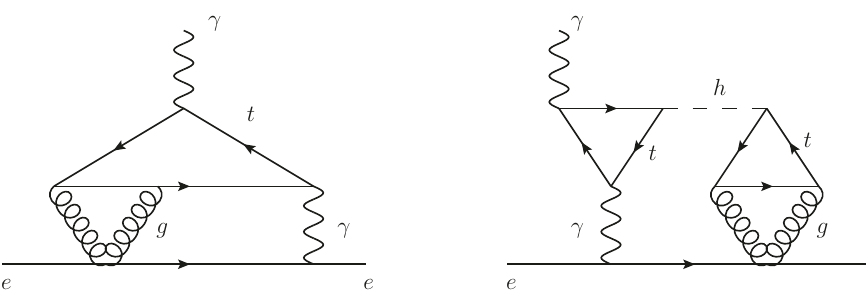
Figure 3 . Representative Feynman diagrams of three (left) or four (right) loop contribution to direct electron EDM from CP-odd electron-gluonic operators. There is no two-loop diagrams con- tributing, because the only diagram at two-loop level is to remove the internal photon line from the left (cid:12)gure. However, this two-loop diagram is forbidden by Furry’s theorem, because after tracing the color indices, it is equivalent to the case in which three photons contact to the same fermion